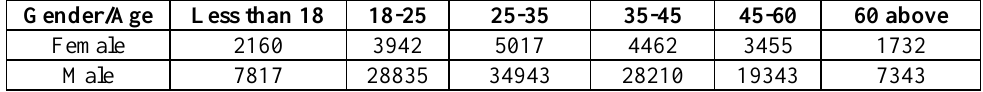
Table 9: Road death based on Gender and Age in 2018.